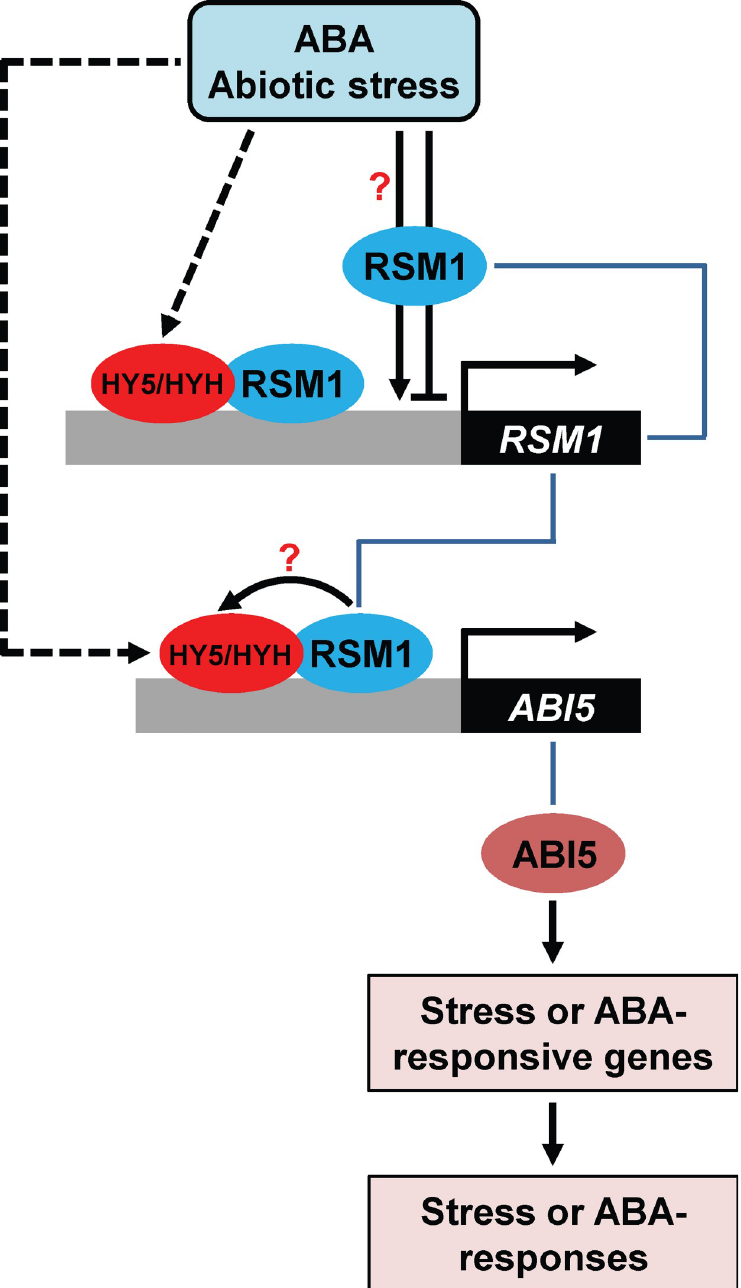
Fig 11. A working model of RSM1 interacting with HY5/HYH and binding with the ABI5 promoter in ABA and abiotic stress signaling. ABA or abiotic stress such as salinity promotes HY5/HYH expression, while activating or suppressing RSM1 expression depending on the duration of exposure to ABA or abiotic stress. RSM1 expression is fine-tuned by auto-regulation by RSM1 and a regulatory loop composed of HY5/HYH. HY5/HYH and RSM1 subsequently regulate ABI5 expression via direct binding to the ABI5 promoter. In this process, RSM1, as a likely partner, interacts with HY5/HYH to enhance their association with the ABI5 promoter. HY5/HYH and RSM1 independently and somehow dependently induce expression of ABI5 and ABI5-targeted genes, thereby modulating ABA and abiotic stress responses.